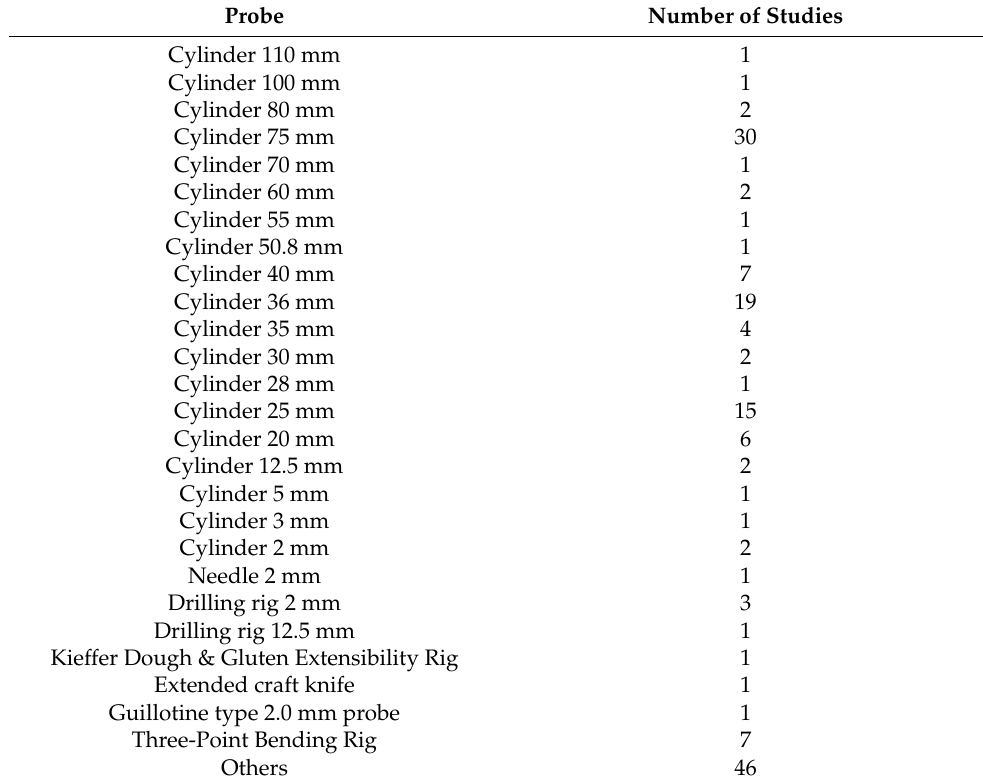
Table 3. More common probes are used for texture measurement in bakery products.